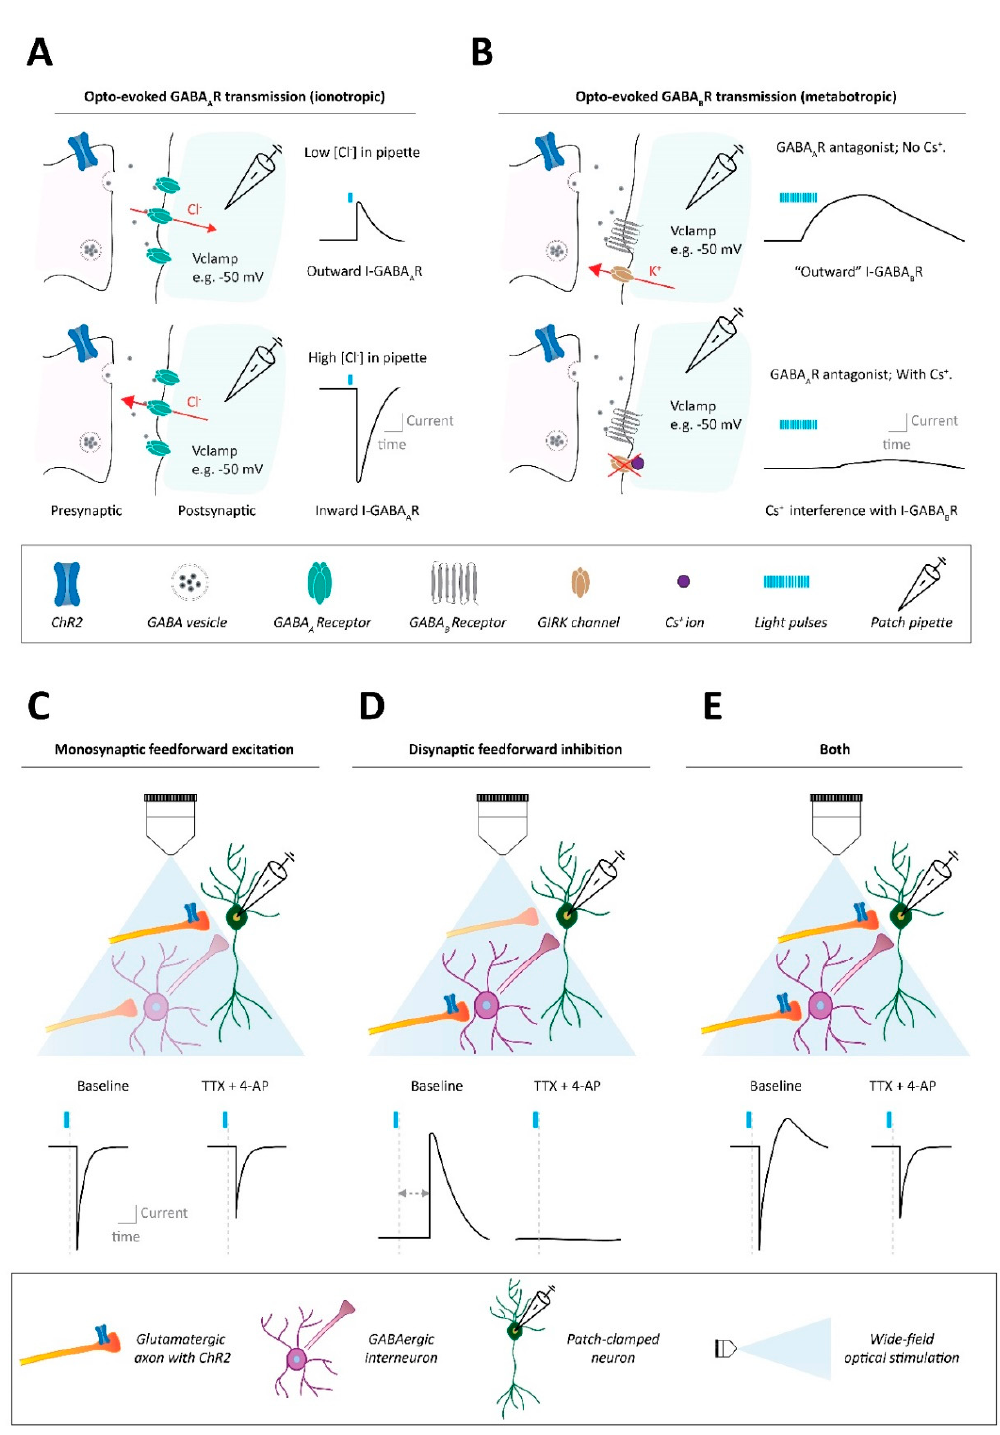
Figure 1. Methods to assess synaptic connectivity in neural circuits. ( A ) Ionotropic synaptic transmission assessed with optogenetic approaches, using single pulse stimulation. Example of GABA A R synaptic transmission. Top: Using a patch pipette solution with a low-chloride ion